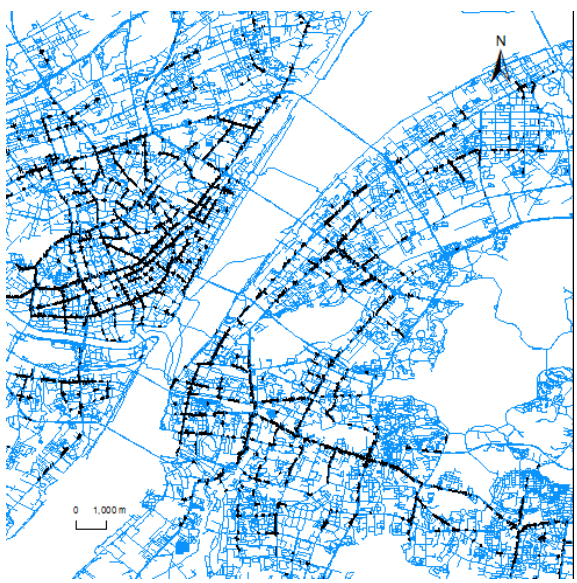
Figure 4. POIs in General